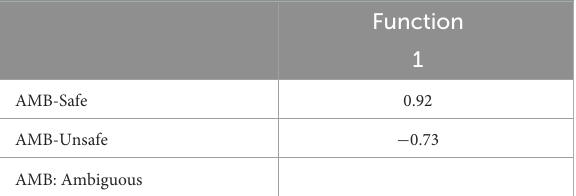
TABLE 6 Within-groups correlations between discriminating variables and standardized canonical discriminant